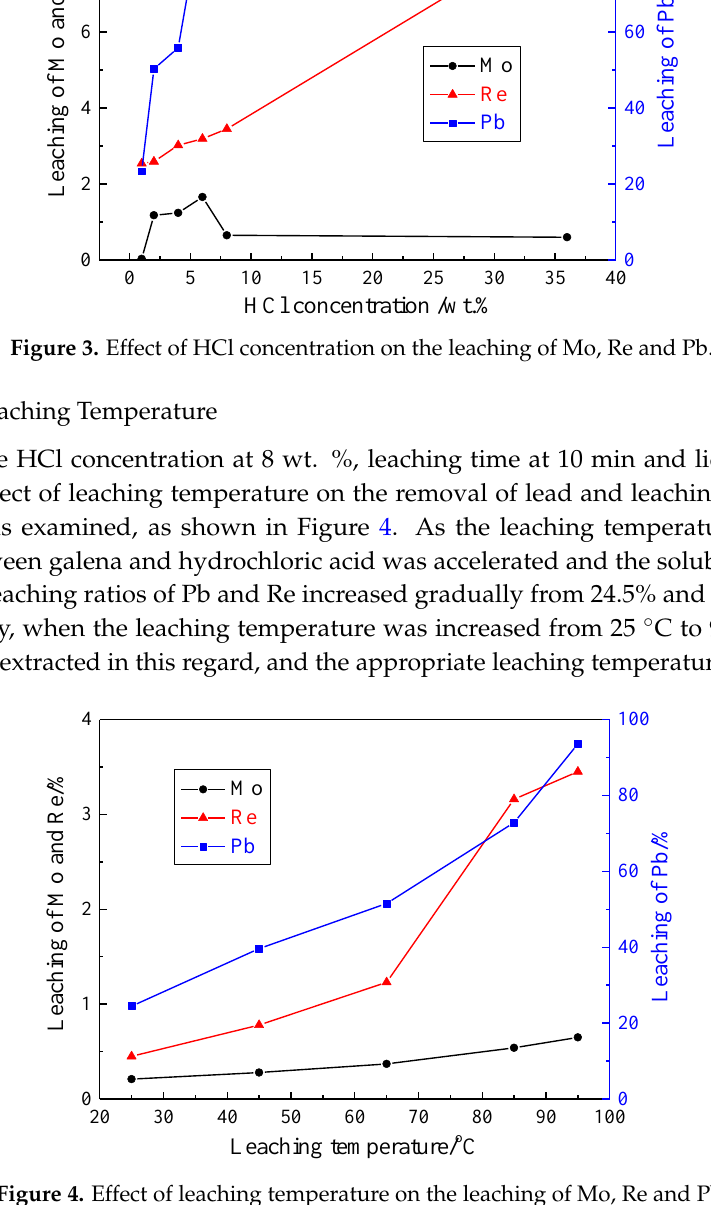
Figure 4. Effect of leaching temperature on the leaching of Mo, Re and